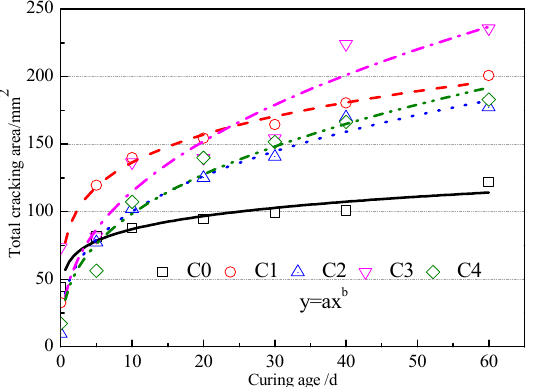
Figure 14. Relationship between total cracking area and curing